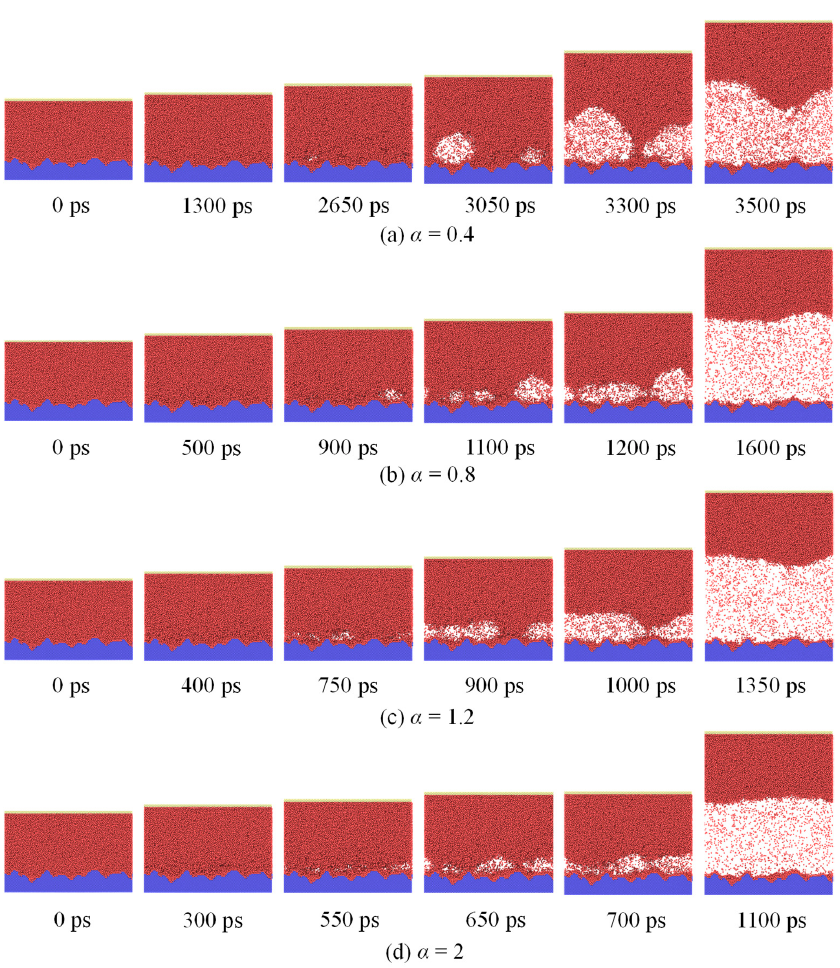
Figure 5. Snapshots of nucleate boiling of liquid argon on nanostructured surfaces with different solid–liquid interactions. ( a ) α = 0.4; ( b ) α = 0.8; ( c ) α = 1.2; ( d ) α = 2.